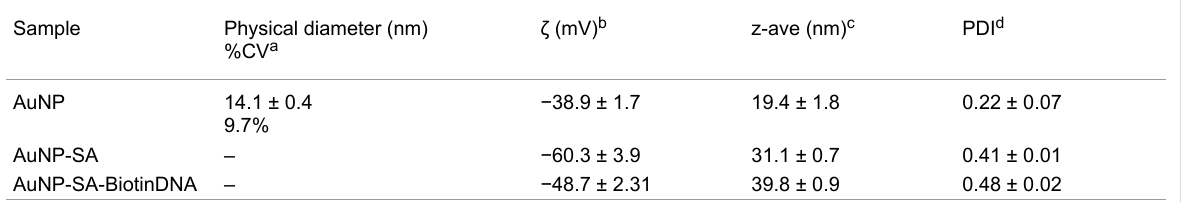
Table 1: Data from TEM, DLS and zeta potential characterization of nanoparticles (mean ± SD; n = 6 samples × 3 replicate). 0.1 nM nanoparticle dispersion in H 2 O. Sample